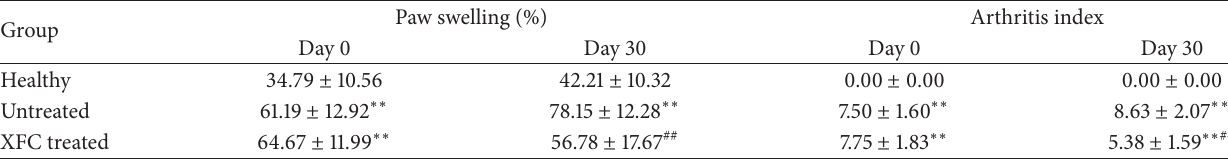
Table 1: Effects of XFC on paw swelling and arthritis index in AA